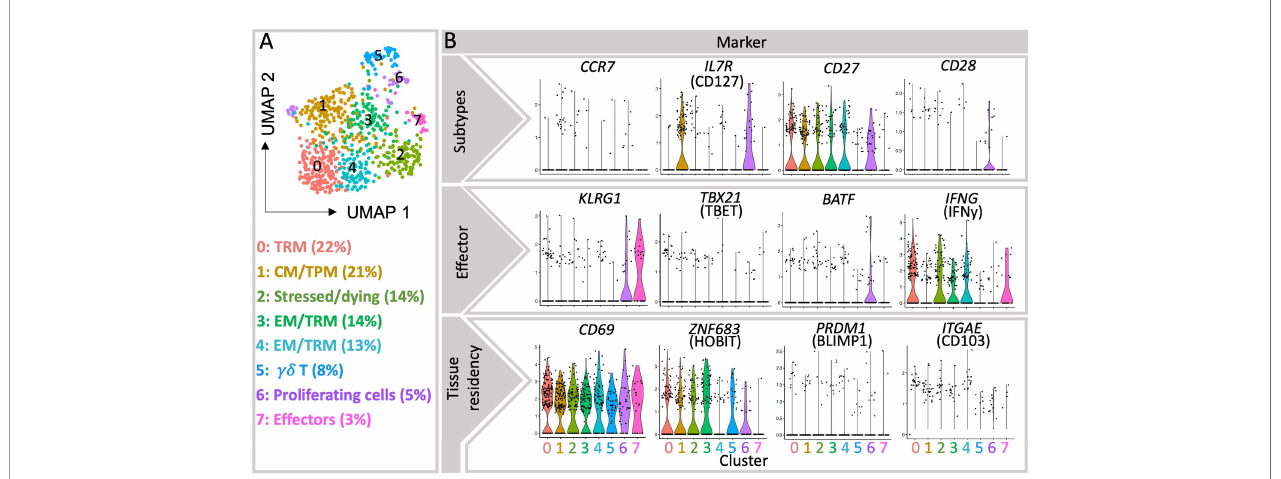
FIGURE 1 | Single-cell transcriptomic analysis of decidual CD8+ T cells from publicly available database. (A) UMAP visualization of ∼ 735 live MS4A7- CD3E+ CD8A + single cell transcriptomes obtained from the decidua of three healthy fi rst trimester pregnancy samples (15). Each symbol (circle) represents a cell, and the colors indicate the eight clusters identi fi ed by Seurat. (B) Violin plots show the gene expression of selected genes in each cluster, particularly of TRM-associated transcription factors Hobit and Blimp1, as well as Tbet and BATF, associated with effector differentiation (11). More detailed information in the expression of relevant markers is provided as heatmaps ( Supplementary Figure 2